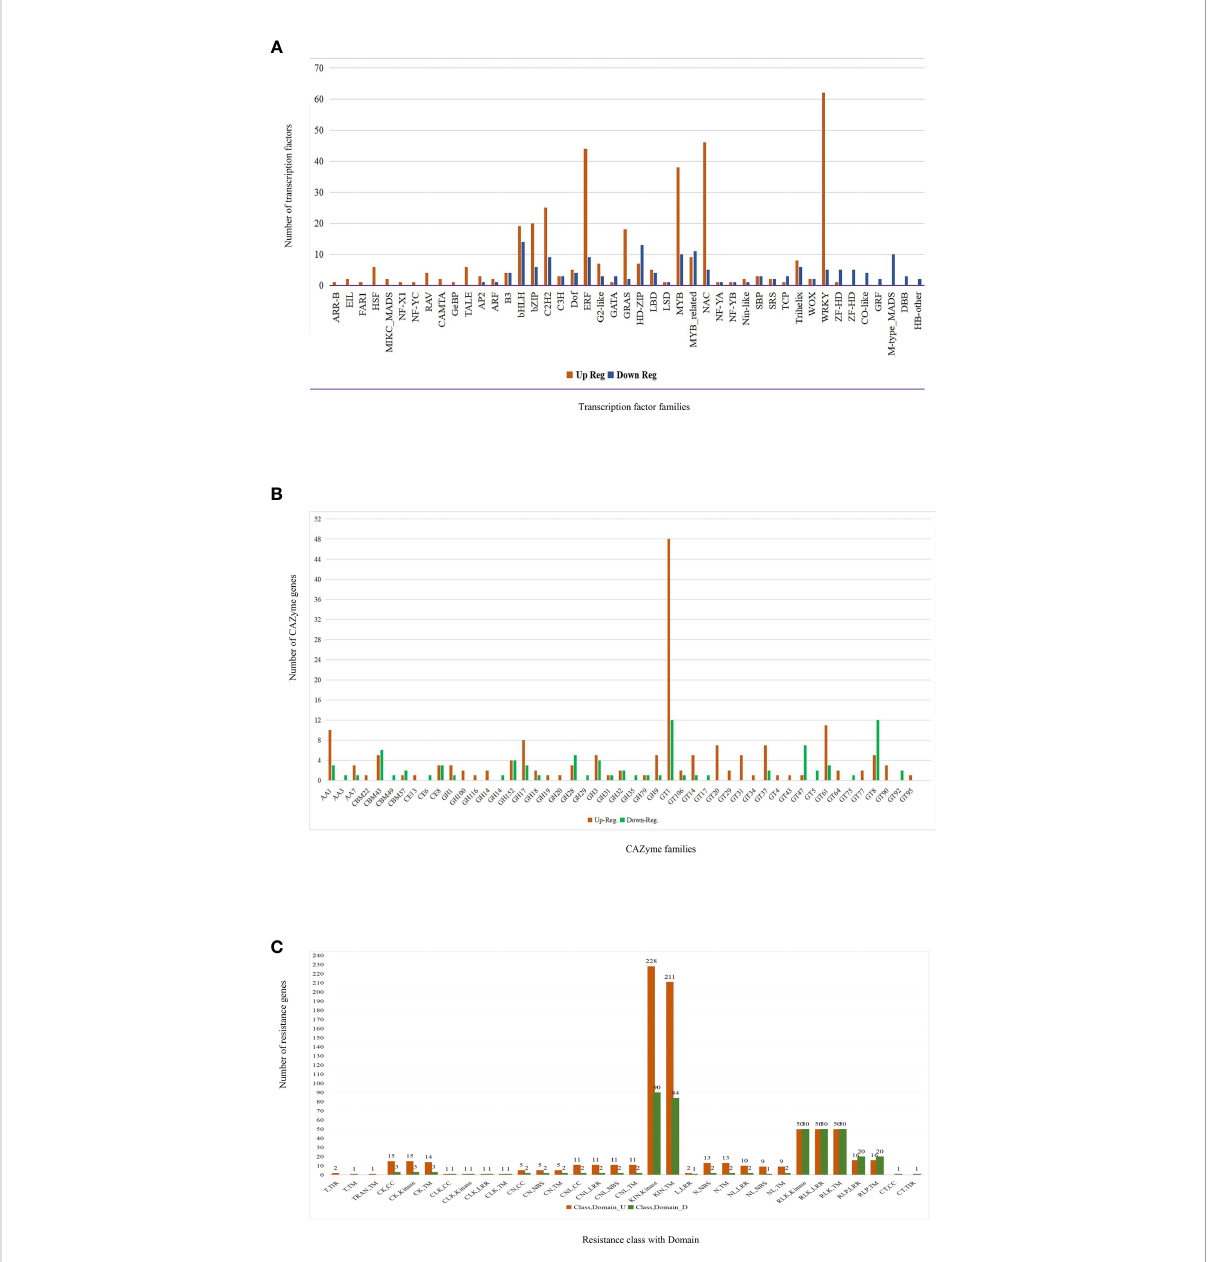
FIGURE 6 Circulation of differentially expressed genes. (A) Transcription factor, (B) CAZyme annotation, and (C) resistance genes identi fi ed from core genes. (GT, Glycosyl Transferase; CBM, Carbohydrate-Binding Modules; GH, Glycoside Hydrolase; AA, Auxillary Activities; CE, Carbohydrate Esterases; KIN, Kinases; RLK, Receptor-like kinases; RLP, Receptor-like proteins consisting an LRR repeat; CK, coiled-coil structure; CLK, Contains coiled-coil; LRR and Kinase domains CNL, CC-NB-LRR; L, Leucine-Rich Repeat; N, Nucleotide-binding site; T, Toll-Interleukin Receptor-like; TRAN, transmembrane